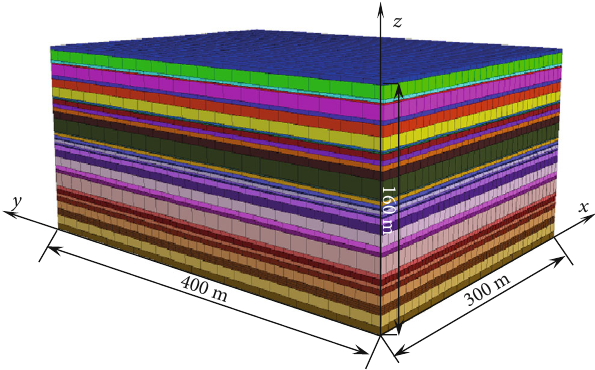
Figure 5: #10 coal seam numerical